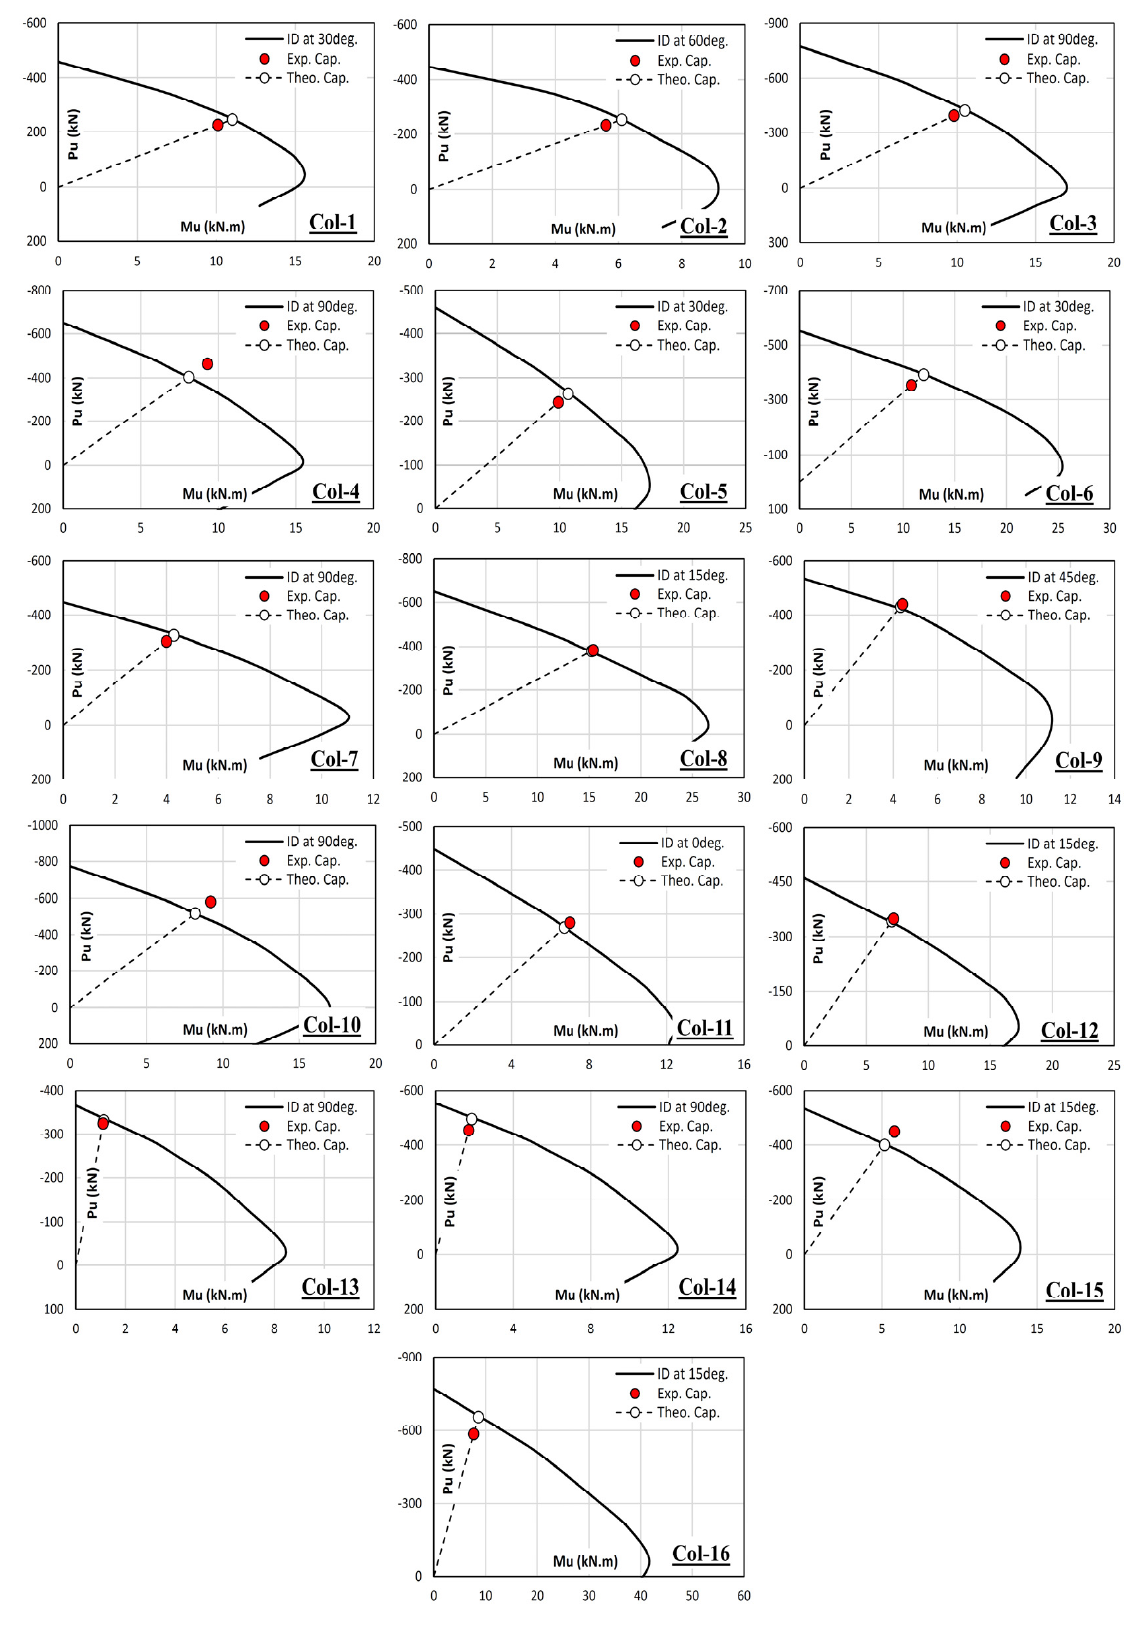
Figure 7. CSI-COL interaction diagrams for the tested specimens.